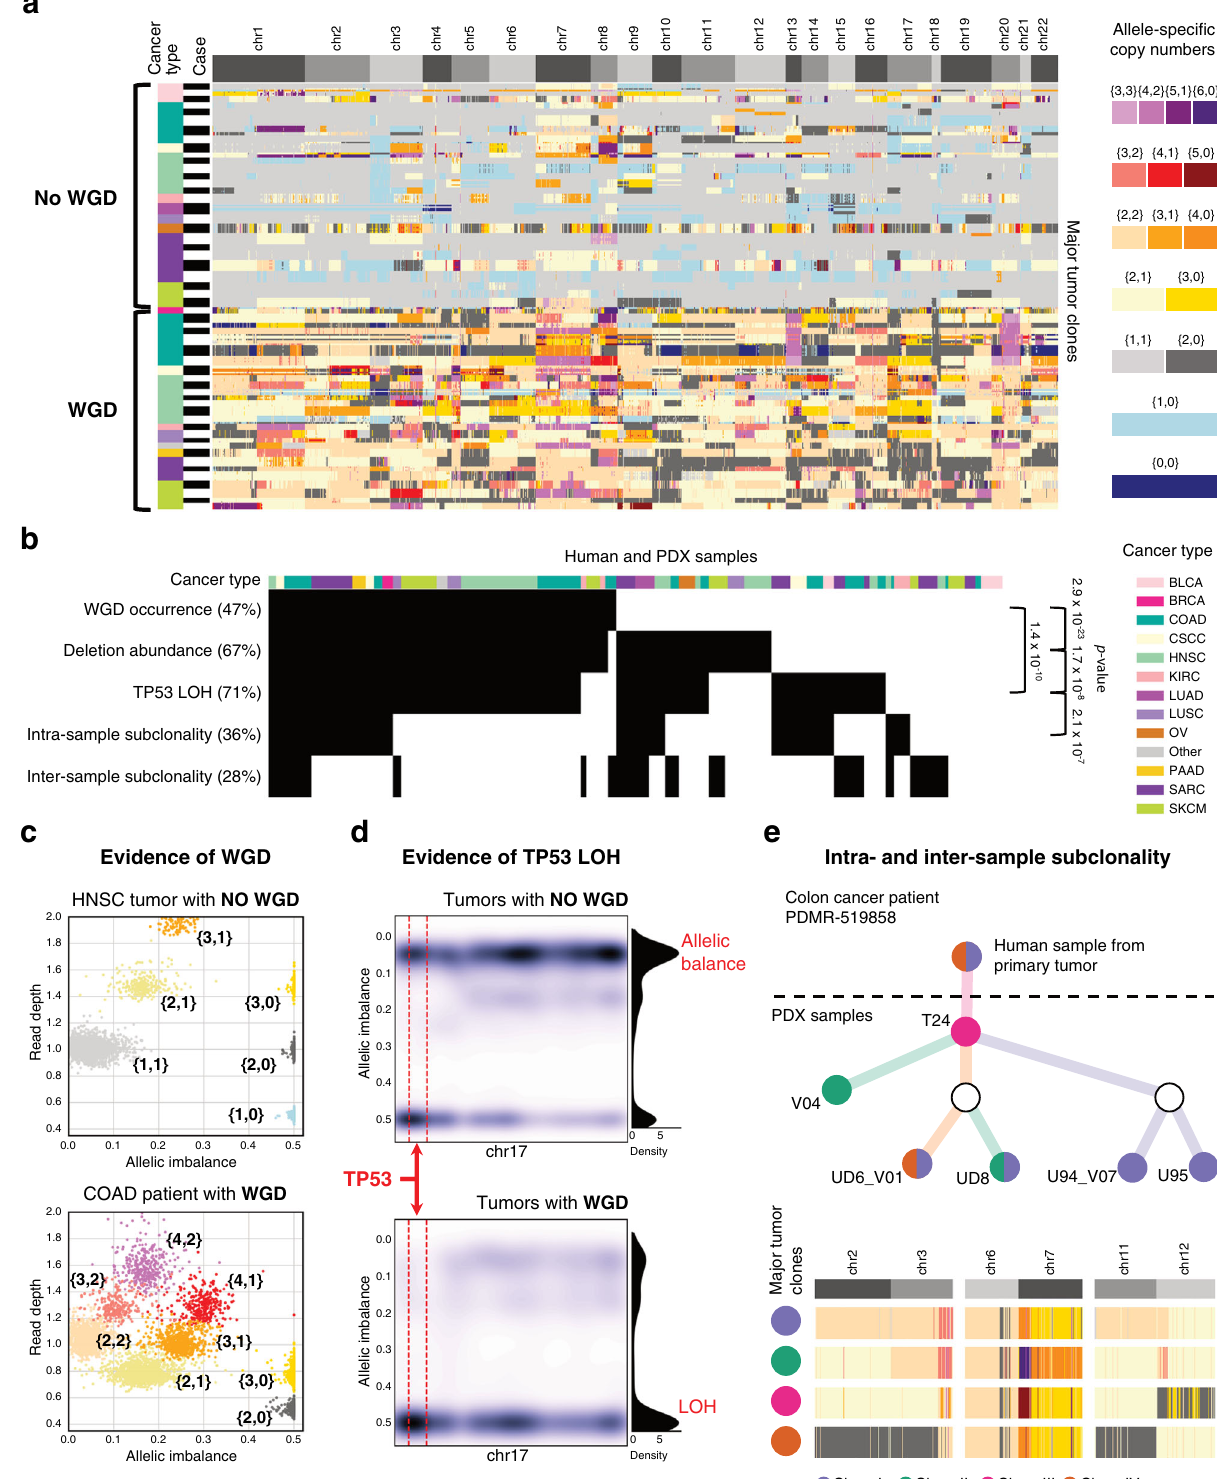
In accordance with recent pan-cancer studies 55,56 , we observed the existence of tumor clonal evolution. Analysis of cases with multiple PDX models shows a higher intra-mutational similarity that whole-genome duplications (WGDs) are relatively frequent compared to inter-mutational similarity, suggesting intrinsic (~50%) across human and PDX samples. Notably, we also con- fi rmed a signi fi cant correlation between WGDs and both abun- tumor heterogeneity among different tumor segments. In contrast to these mutational features, we observed a rapid CNV evolution dance of deletions and LOH of TP53 56,58 . Moreover, our study in several PDX models, consistent with a previous study 69 . shows that the LOH of TP53 is also signi fi cantly correlated with NATURE COMMUNICATIONS|